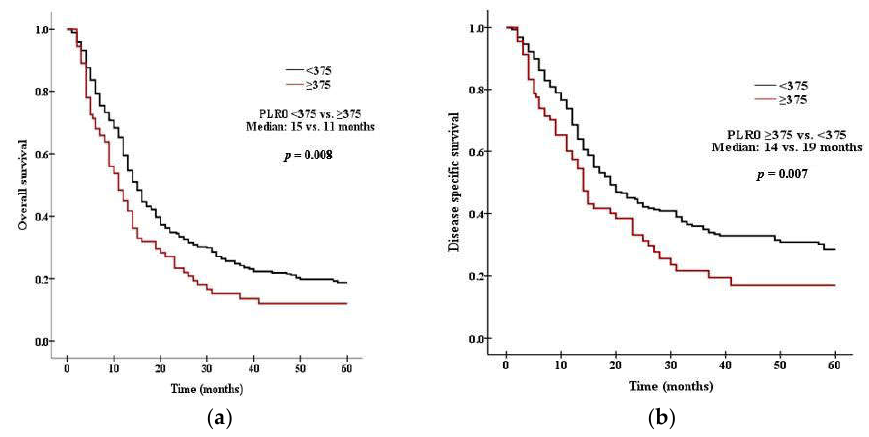
Figure 1. Kaplan–Meier curves of ( a ) OS in patients with PLR0 < 375 versus PLR0 ≥ 375, ( b ) DSS in patients with PLR0 < 375 versus PLR0 ≥ 375.